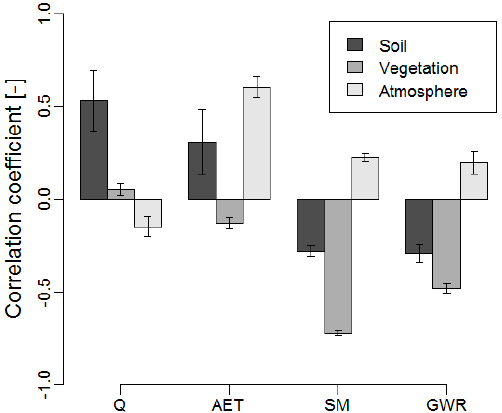
Figure 7. Correlation coefficient calculated between the spatial dis- tributions of the uncertainty (CV) of the simulated model outputs ( Q is runoff; AET is actual evapotranspiration; SM is soil moisture; GWR is groundwater recharge) and local environmental conditions (the clay (%) is used to represent the soil; annual mean leaf area index LAI (m 2 m − 2 ) is used to represent the vegetation; cumulative potential evapotranspiration PET (mmyr − 1 ) is used to represent the atmospheric water demand). The bars represent the mean of the cor- relation coefficients obtained with the three perturbation methods and the error bars the standard deviation.